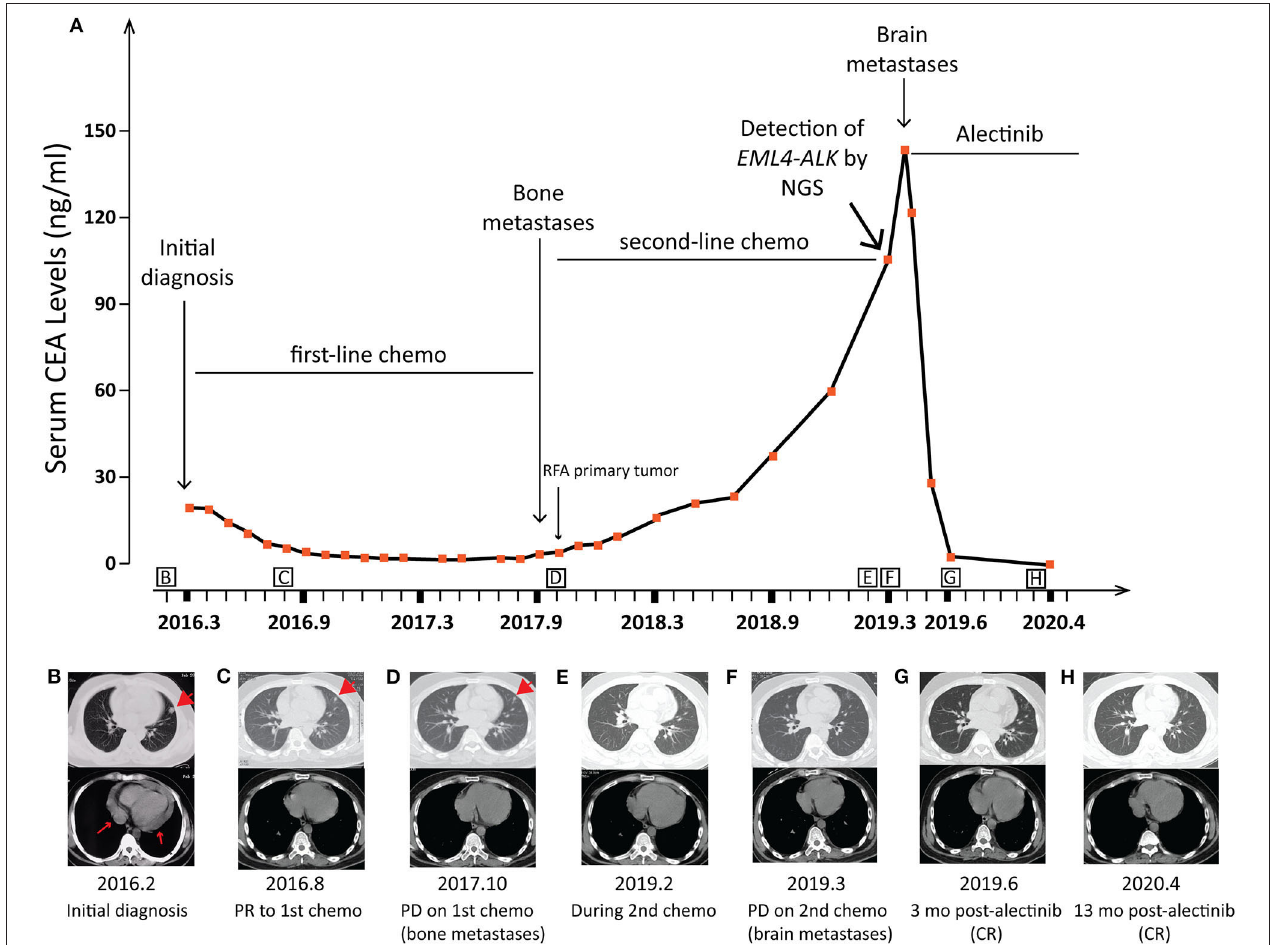
FIGURE 1 | Schematics showing the patient’s treatment history. (A) A diagram showing the chronological changes of therapeutic regimens and serum CEA levels during the entire course of treatment. RFA, radiofrequency ablation. (B–H) The patient’s chest computed tomography (CT) scans at different clinical time points as shown. Arrowheads: location of the primary lung lesion in different scans. Arrows: paricardial effusion at initial diagnosis. PR, partial response; PD, progressed